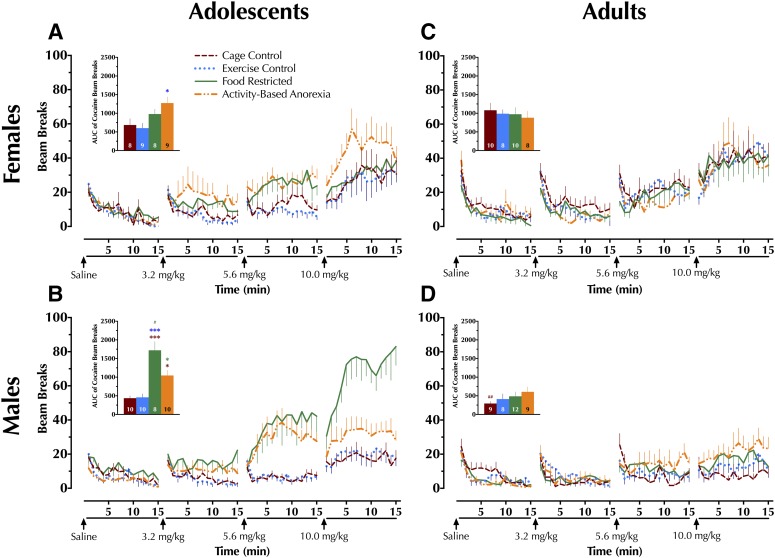
Cocaine-induced locomotion. Rats were habituated to activity chambers for 45 minutes, then injected first with saline (1 ml/kg), then increasing individual doses of cocaine (3.2, 5.6, and 10 mg/kg) at 15 minute intervals in a cumulative-dosing paradigm. Activity was quantified as the number of beam breaks in 1 minute bins (lines in graphs), and the area under the curve (AUC) for all three cocaine doses is cumulatively shown in inset bar graphs for adolescent (A) female and (B) male and adult (C) female and (D) male rats. AUC data (inset bar graphs) were analyzed within each age group with a two-way (sex × condition) ANOVA with Tukey-Kramer’s post-hoc tests where appropriate. Data are graphed as mean ± S.E.M. *P < 0.05; ***P < 0.001 vs. same-sex condition, indicated by color of asterisk(s), within the same age group. #P < 0.05; ##P < 0.01 vs. same condition in females of same age group. Number of animals is indicated at base of each bar.